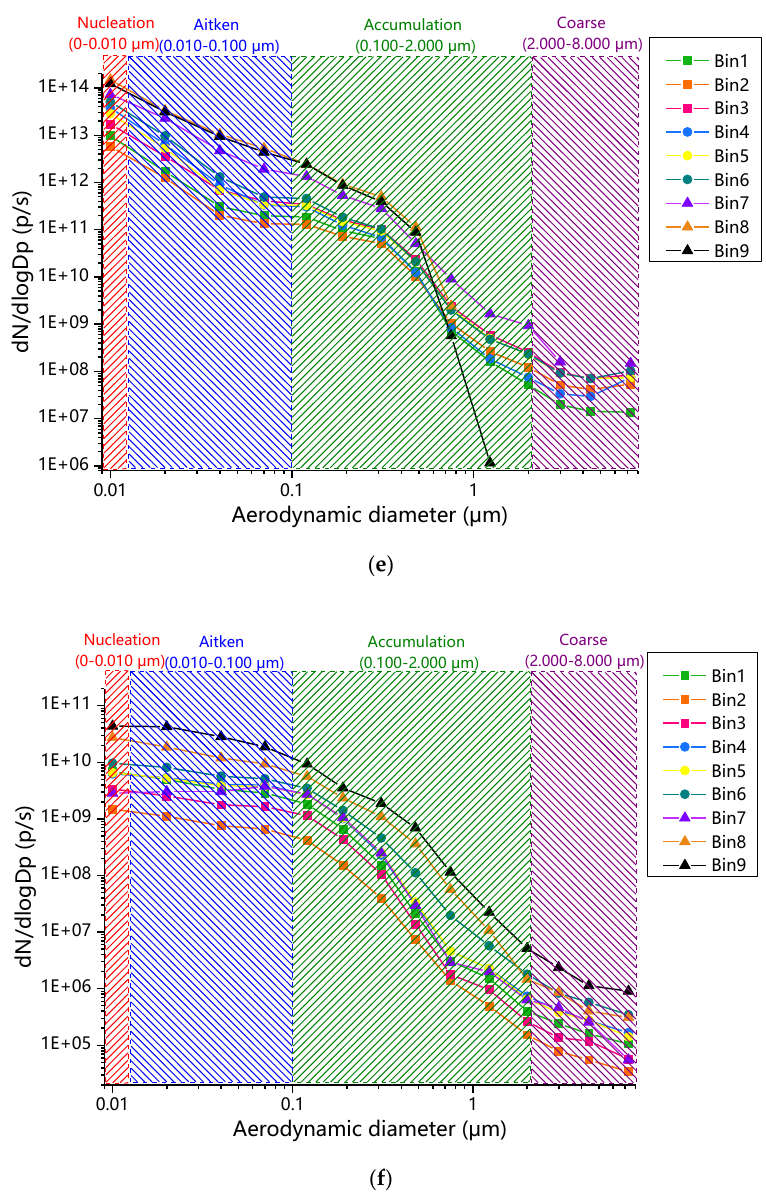
Figure 9. Comparison of the PN size distribution in 9 speed-VSP bins. The speed-VSP intervals: Bin1: Speed ≤ 40 km/h, VSP ≤ −5 kW/t; Bin2: Speed ≤ 40 km/h, −5 kW/t < VSP < 5 kW/t; Bin3: Speed ≤ 40 Speed ≤ 40 km / h, VSP ≤ − 5 kW / t; Bin2: Speed ≤ 40 km / h, − 5 kW / t < VSP < 5 kW / t; Bin3: Speed ≤ 40 km/h, VSP ≥ 5 kW/t; Bin4: 40 km/h < Speed ≤ 80 km/h, VSP ≤ −5 kW/t; Bin5: 40 km/h < Speed ≤ 80 km / h, VSP ≥ 5 kW / t; Bin4: 40 km / h < Speed ≤ 80 km / h, VSP ≤ − 5 kW / t; Bin5: 40 km / h < Speed ≤ 80 km/h, −5 kW/t < VSP < 5 kW/t; Bin6: 40 km/h < Speed ≤ 80 km/h, VSP ≥ 5 kW/t; Bin7: Speed > 80 km/h, km / h, − 5 kW / t < VSP < 5 kW / t; Bin6: 40 km / h < Speed ≤ 80 km / h, VSP ≥ 5 kW / t; Bin7: Speed > 80 km / h, VSP ≤ − 5 kW / t; Bin8: Speed > 80 km / h, − 5 kW / t < VSP < 5 kW / t; Bin9: Speed > 80 km / h, VSP